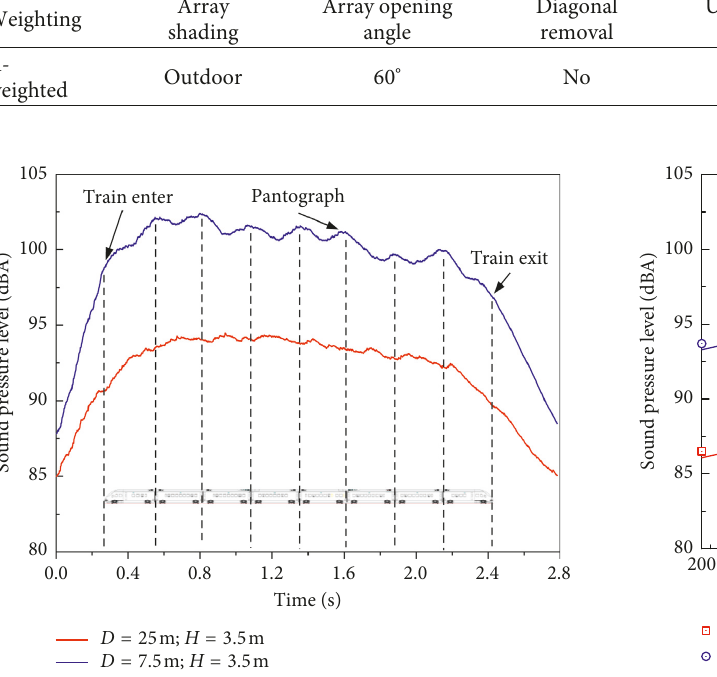
Figure 5: L Aeq , Tp results of the pass-by noise at different speeds.